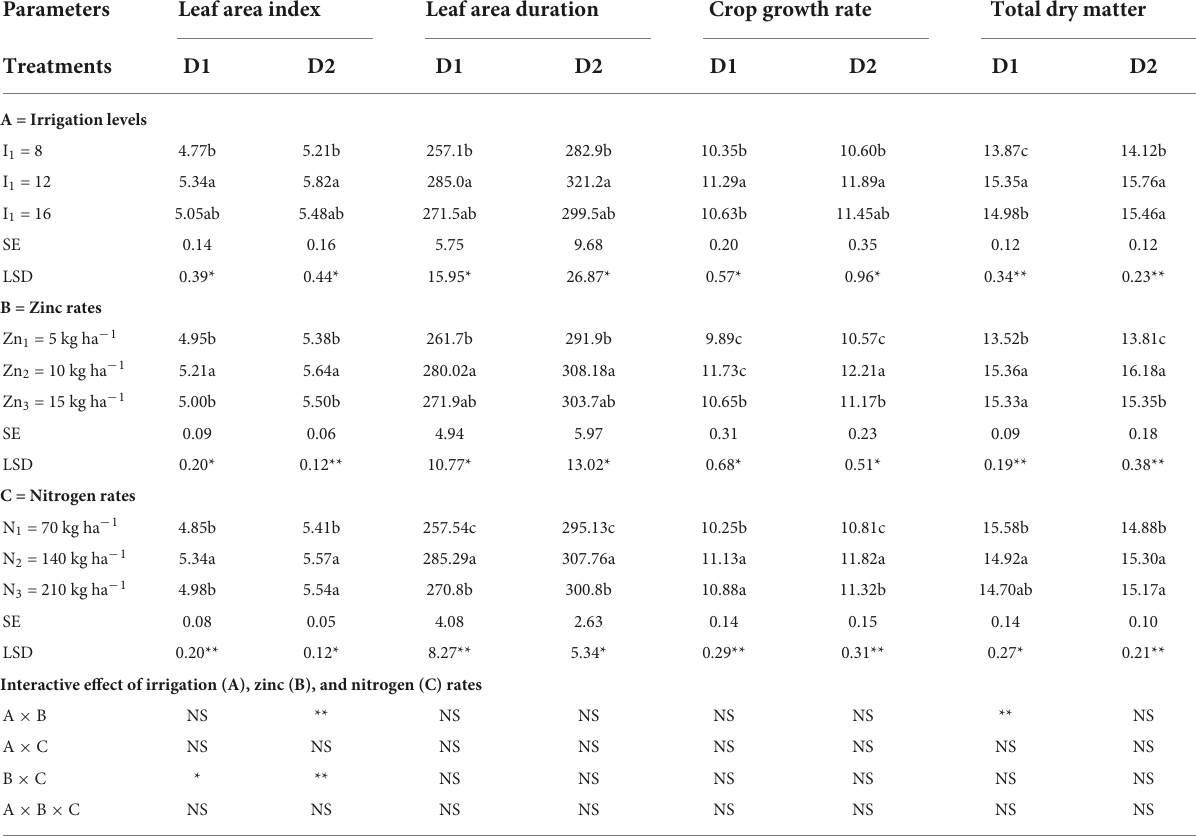
TABLE 5 Impact of zinc and nitrogen rates on leaf area index, leaf area duration, total dry matter and crop growth rate of rice cultivated under three irrigation levels at Sheikhupura (D1) and Sargodha (D2) districts of Pakistan.